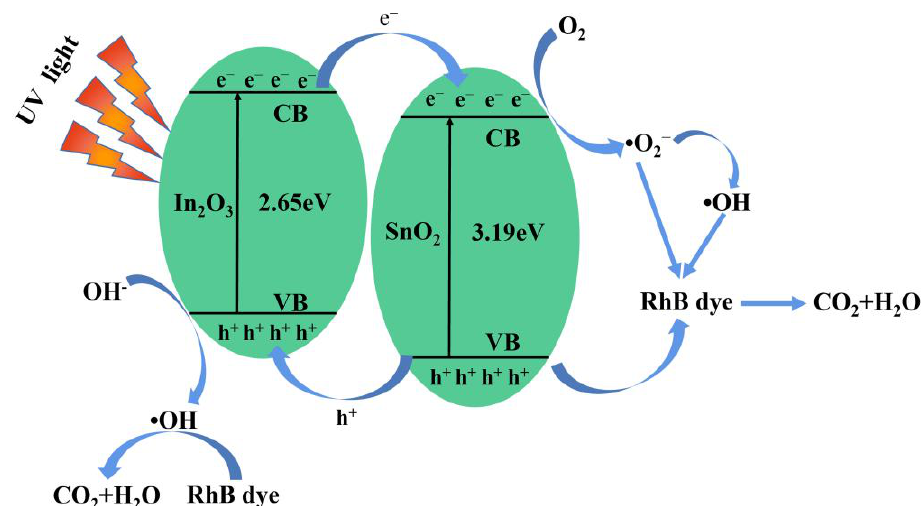
Figure 8. Schematic illustration of the separation and migration mechanism of photogenerated electron–hole pairs of In 2 O 3 /SnO 2 composites.